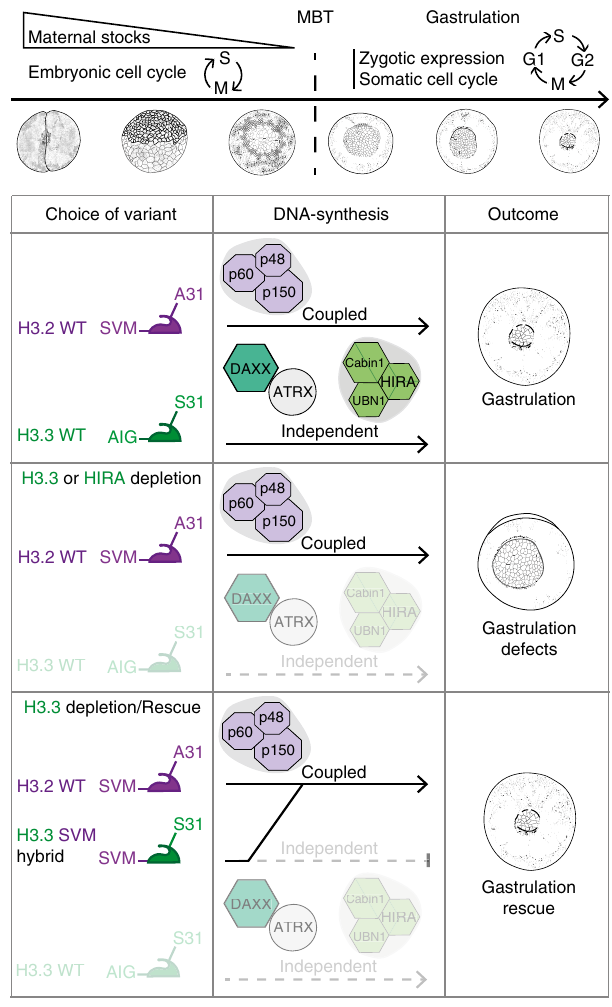
Fig. 8 Model. Defects associated with H3.3 depletion can be rescued with H3 histone variants carrying a potential negatively charged residue, regardless of the mode of incorporation. MBT: midblastula